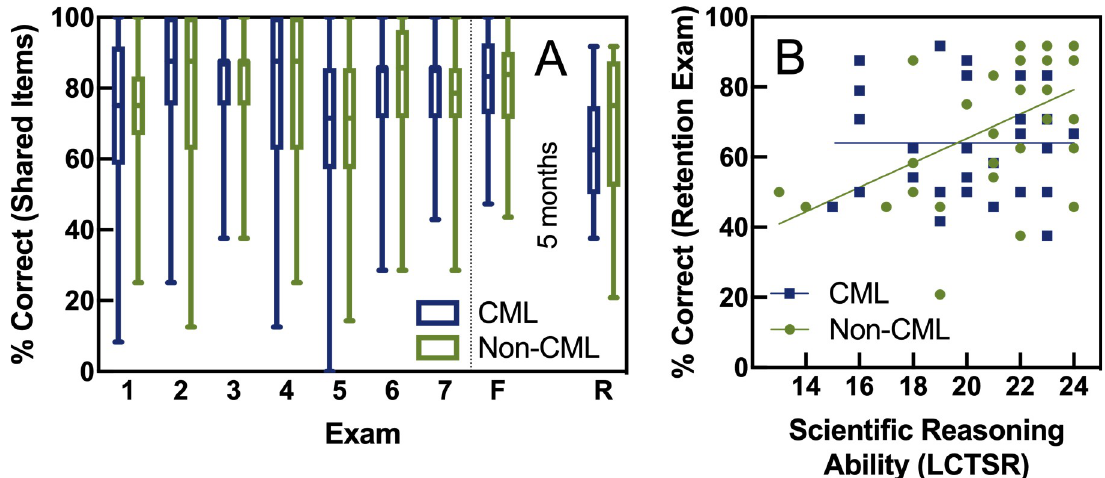
Fig 4. Effect of cumulative midterms on exam scores. Panel A: The y axis shows percent correct for midterms one through seven (calculated using only test items that were shared between cumulative, blue, and non-cumulative, green, sections), the final exam (F), and the retention exam (R) five months after the semester ended. Panel B: Retention exam scores are shown on the y axis and LCTSR scores are on the x axis. Lines are from a simple linear regression and show different relationships between scientific reasoning and retention for the non-cumulative (slope = 3.48, R 2 = 0.27, p = 0.003) and cumulative (slope = -0.001, R 2 = 0.00, p = 0.99)